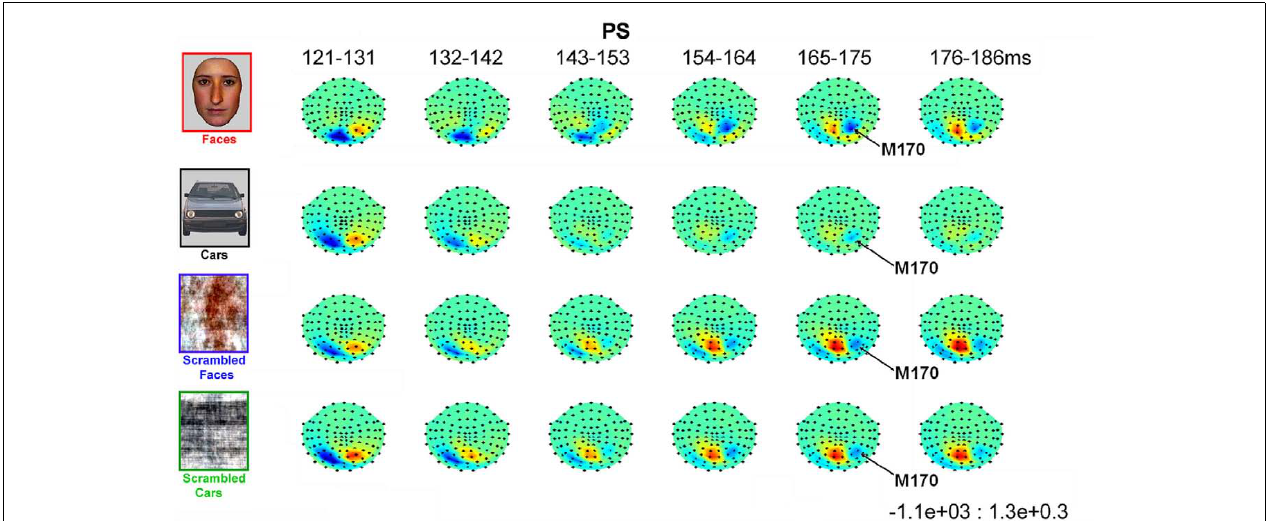
between sensors, indicated by black dots, after their spherical projection onto a 2D surface). Red and blue indicate outward and inward radial direction of magnetic flux through single flux coils within the helmet (in units of fT).